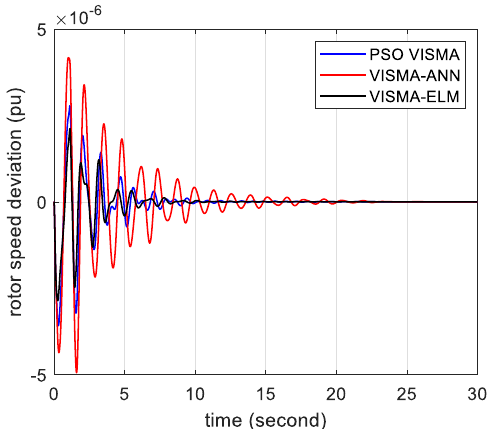
Figure 15. Rotor speed responses of G3 under different methods.